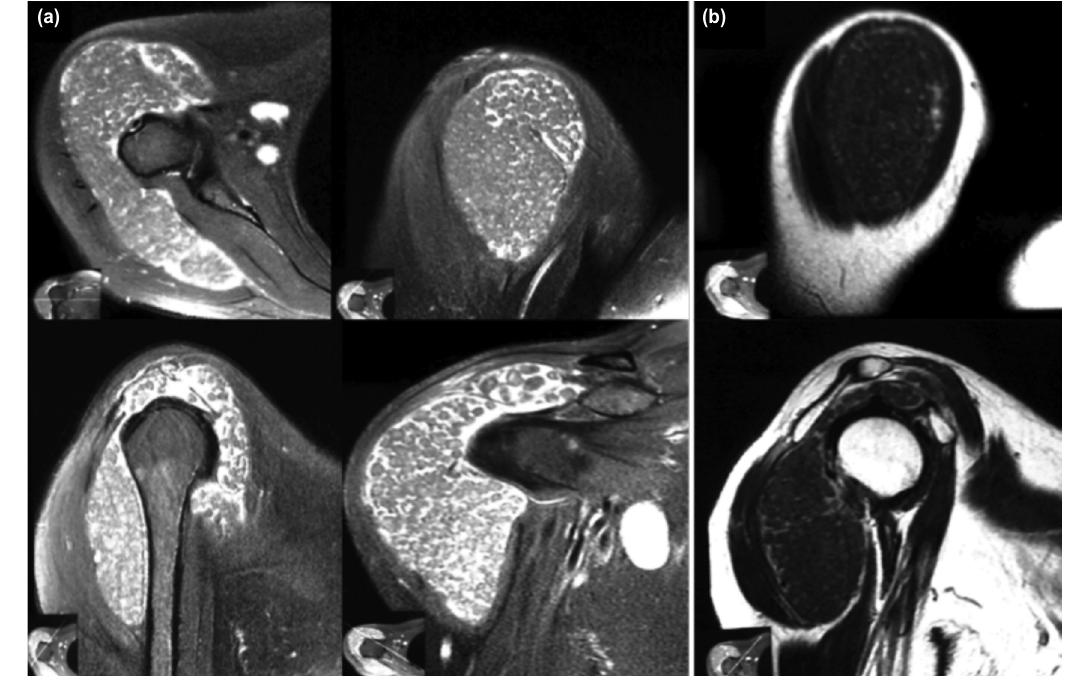
(a) MRI of right shoulder axial, coronal and sagittal T1 weighted images showing multiple iso-intense rice bodies. (b) MRI of right Fig. 2: shoulder T2 weighted images showing hypo-intense rice